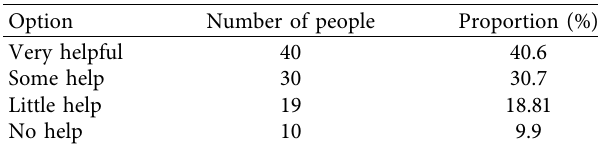
Table 1: Whether the optimized psychoeducational curriculum is helpful in life.